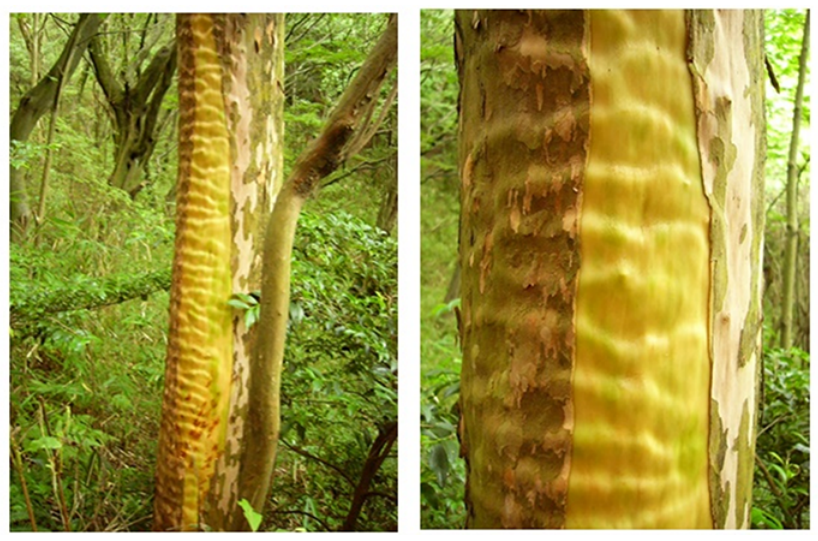
Figure 4 Clethra barbinervis – Individual tree with numerous horizontal ripples covering half of its circumference; the bark of the tree has been partially stripped off by a grazing deer; brownish marks of the teeth of the animal can be seen at the bottom of the